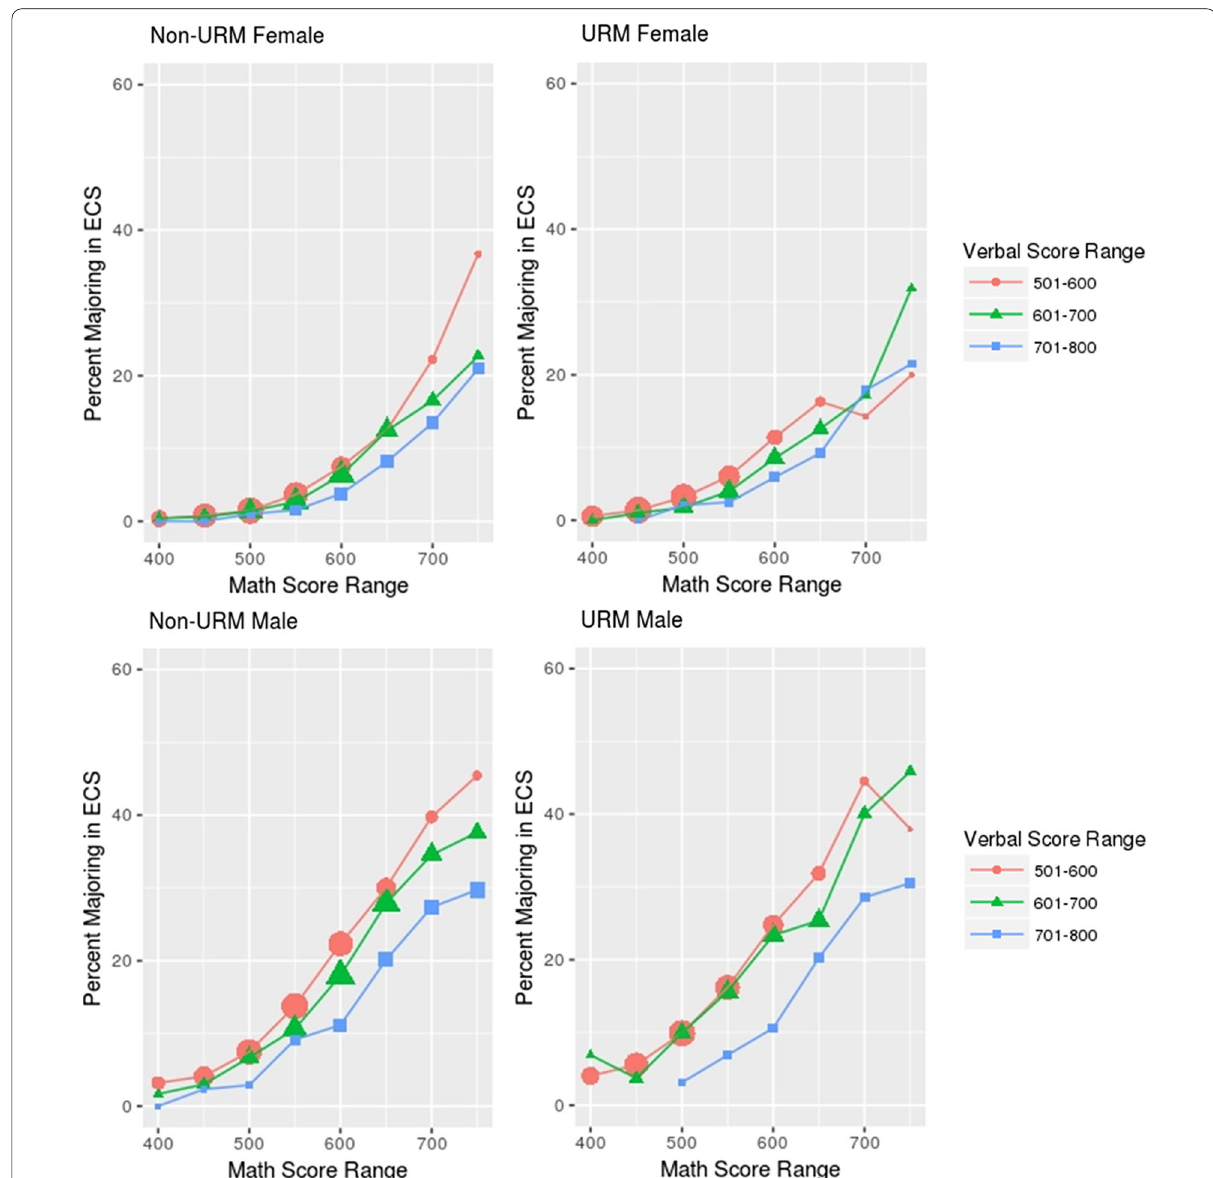
Fig. 2 The percentage of male/female and URM/non-URM students enrolling in a 4-year college ECS program based on SAT scores. The size of the shapes (dots, triangles, and squares) represents the number of students in each SAT verbal and math score combination, with larger shapes representing greater number of